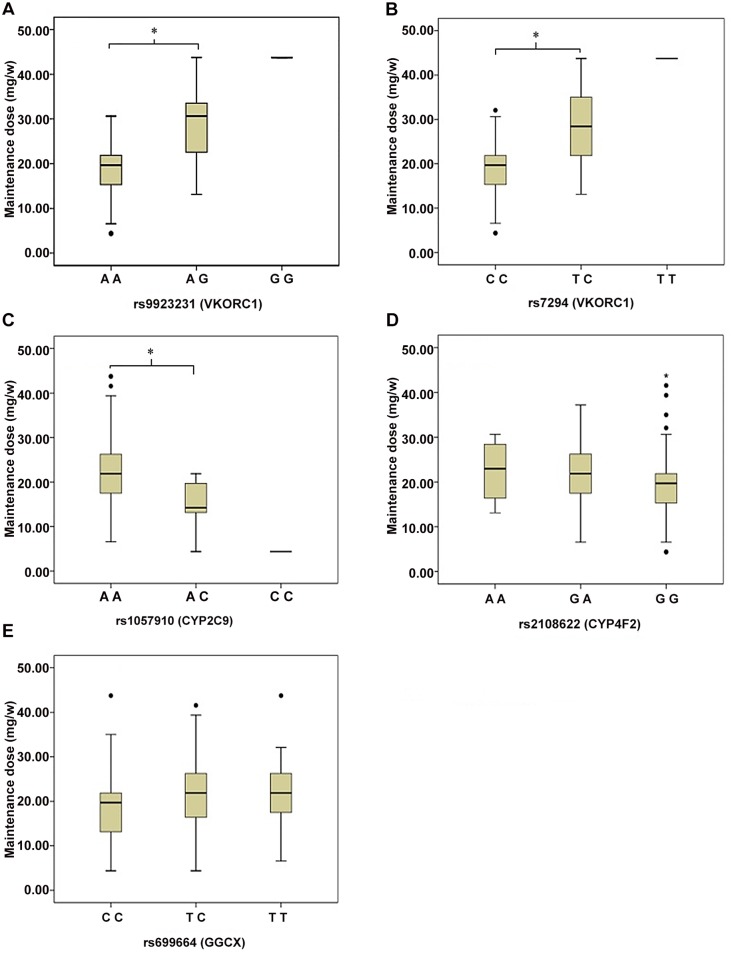
Relation between the maintenance dose and the tested genes.Panel A–E: rs9923231 (Panel A), rs7294 (Panel B), rs1057910 (Panel C), rs2108622 (Panel D), rs699664 (Panel E). Each box indicates 25 to 75 percentile of values, and the horizontal lines represent the median value of maintenance dose. *: p < 0.05 at ANOVA test.